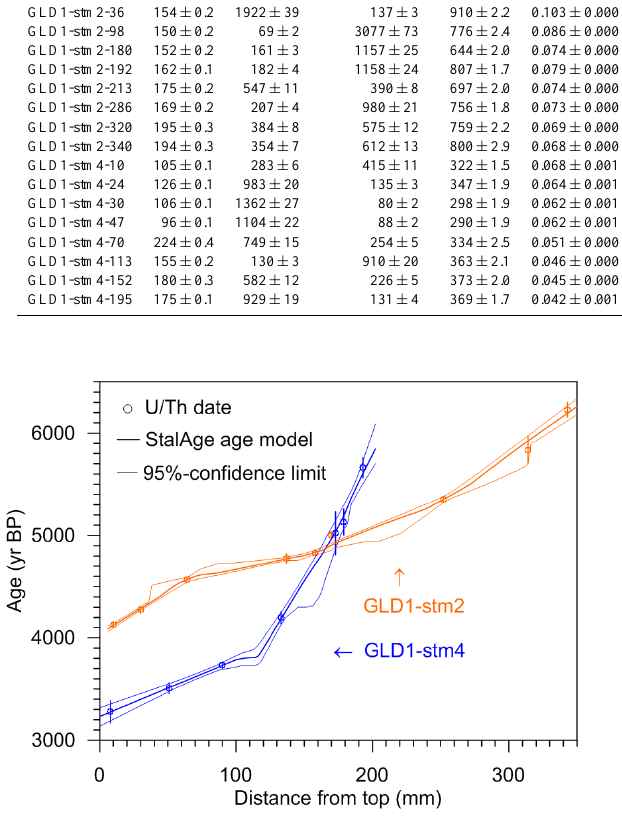
Figure 3. Age models of stalagmites GLD1-stm2 and GLD1-stm4 from the Gueldaman GLD1 Cave. The age models were calculated using the StalAge program (Scholz and Hoffmann, 2011). Note that the U/Th date of sample GLD1-stm4-47 was detected as a major outlier and not used in the final age model of stalagmite GLD1- stm4. The 2 σ analytical uncertainty of each U/Th date (dot) is rep- resented by the error bars, whereas the 95% uncertainty assessed from the model simulation is represented by thin